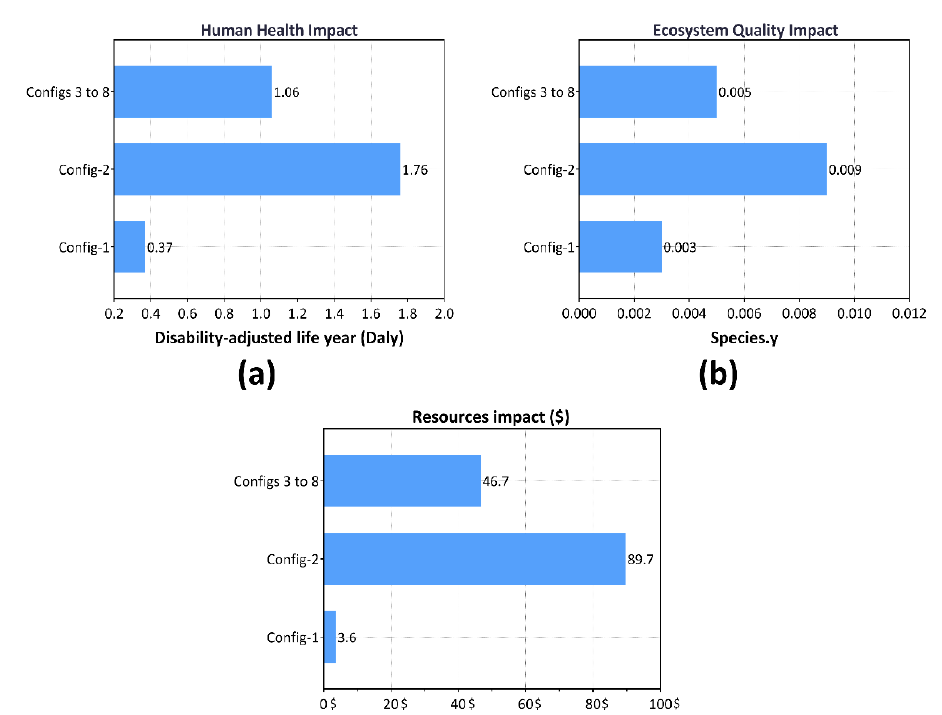
While the highest HHI was calculated as 1.46 DALY for Config ‐ 2, the lowest HHI was found as 2.88 × 10 − 6 DALY for Config ‐ 1. The highest HHI values, around 80% of the total impact, were observed in the climate change midpoint. Among the configurations, the highest EQI was found as 0.0083 species.yr in Config ‐ 2. Such results in HHI have not been observed in the EQI. Only in Config ‐ 2 and Configs ‐ 3 to 8, the highest value was seen at the climate change midpoint, while in Config ‐ 1 it was in agricultural use areas. The highest EQI values for Config ‐ 1, Config ‐ 2, and Configs ‐ 3 to 8 were calculated as 0.0026, 0.0083, and 0.0049 species.yr, respectively. In addition, the lowest EQI value was found to be 2.66 × 10 − 8 (in Marine ecotoxicity midpoint) in Config ‐ 1. Finally, the RI values for Con ‐ fig ‐ 1, Config ‐ 2, and Configs ‐ 3 to 8 were calculated as $3.60, $89.70, and $46.70, respec ‐ tively. The RI value was highest in Config ‐ 2 and lowest in Config ‐ 1. The total values of HHI, EQI, and RI are shown in Figure 9.